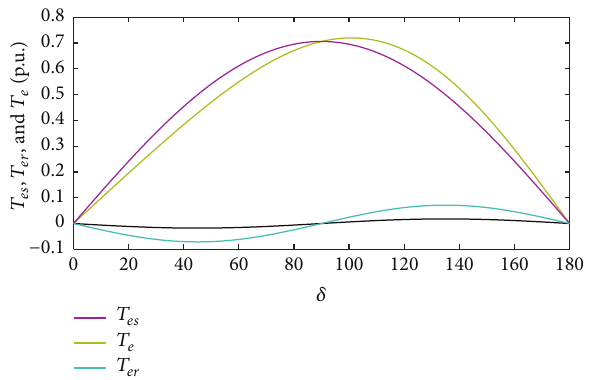
Figure1:Synchronous,reluctance,andairgaptorquesversustorque angle ( 𝛿